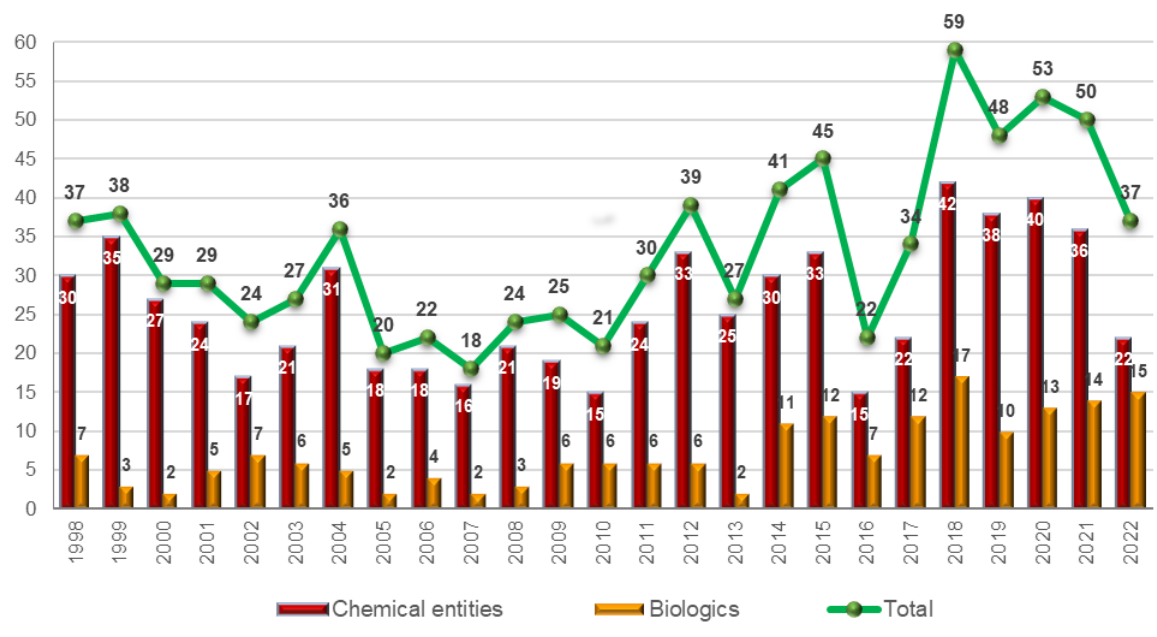
Figure 1. Drugs (new chemical entities and biologics) approved by the FDA in the last 25 years [1 – 3]. Adapted with permission from Ref. [1]. Copyright 2022, copyright MDPI